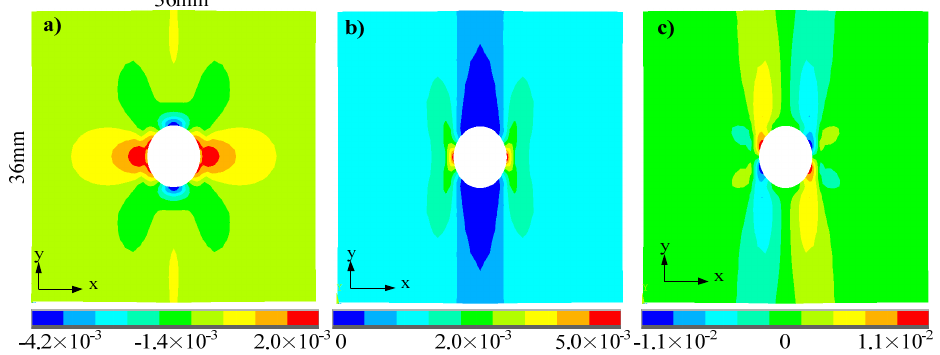
Figure 3. Strain distribution derived from FE model while hole diameter φ = 6 mm and fiber angle θ = 90 ◦ : ( a ) ε x ; ( b ) ε y ; ( c ) γ